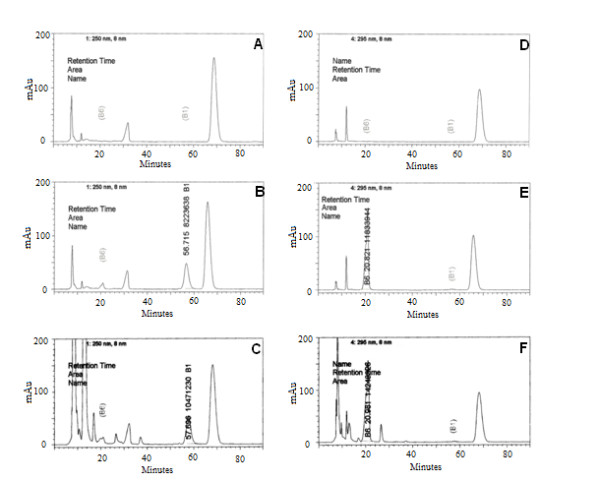
Specificity of the vitamin B1 and B6 assay. Chromatograms of PN placebo (A and D), spiked with the B1 and B6 (B and E) and PN containing the multivitamin (C and F) obtained by HPLC at wavelength of 250 and 295 nm, respectively, using column of reverse phase C18 and a mixture of methanol:water (27:73, v/v) and sodium hexano sulfonate 1,4%, pH 3.0 as mobile phase (n = 3).